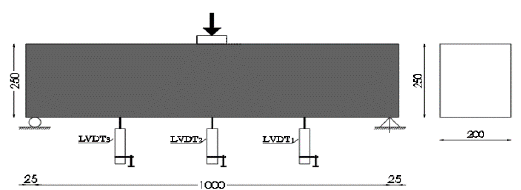
Figure 10. Details of the tested beam (B1).